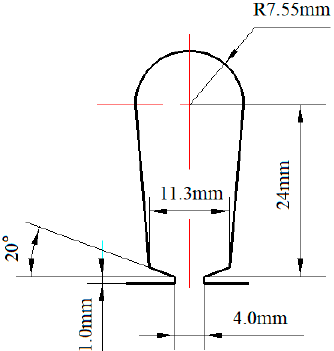
Figure 3. Dimensions of the stator slots.